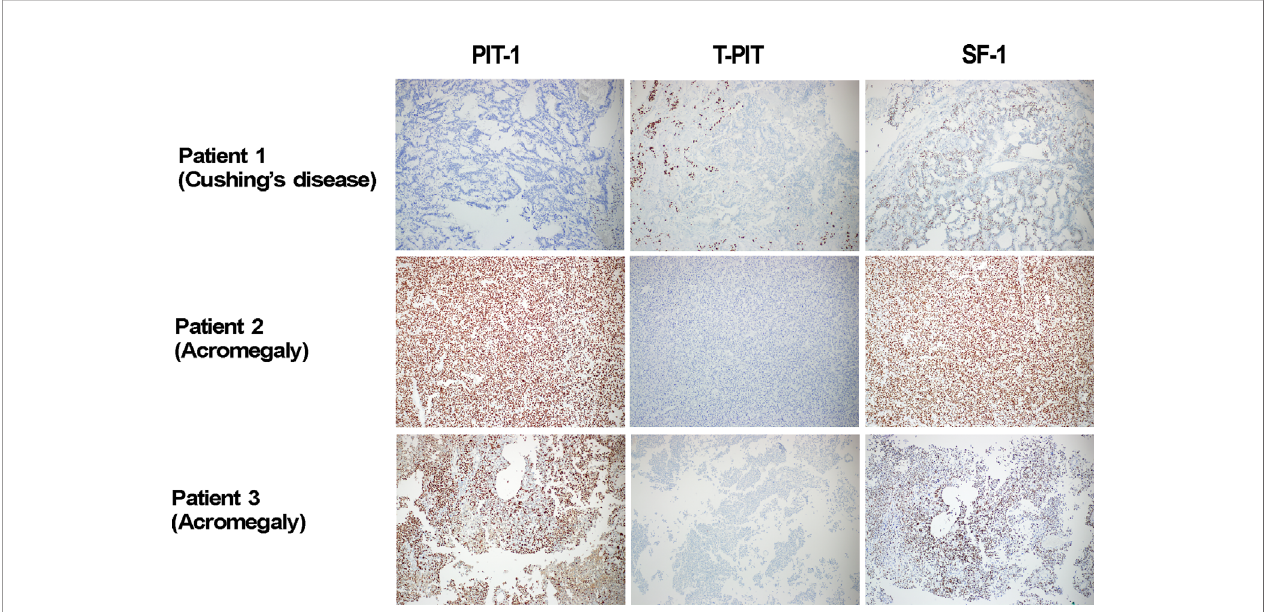
FIGURE 2 | Three tumor cases with positive IHC for multiple transcriptions factors. In our prospective investigation on 484 pituitary adenomas, three unusual cases were identi fi ed as their cell lineages were not clearly classi fi ed. They were 1 Cushing ’ s disease patient with positive IHC for T-PIT, and SF-1, and two acromegalic patients with positive IHC for both PIT-1 and SF-1. In Patient 2, positive stains for PIT-1 and SF-1 were observed in the same cells. PIT-1, T-PIT and SF-1 X 100. IHC, immunohistochemistry; PIT-1, pituitary speci fi c transcription factor 1; SF-1, steroidogenic factor 1; T-PIT, pituitary cell restricted factor.